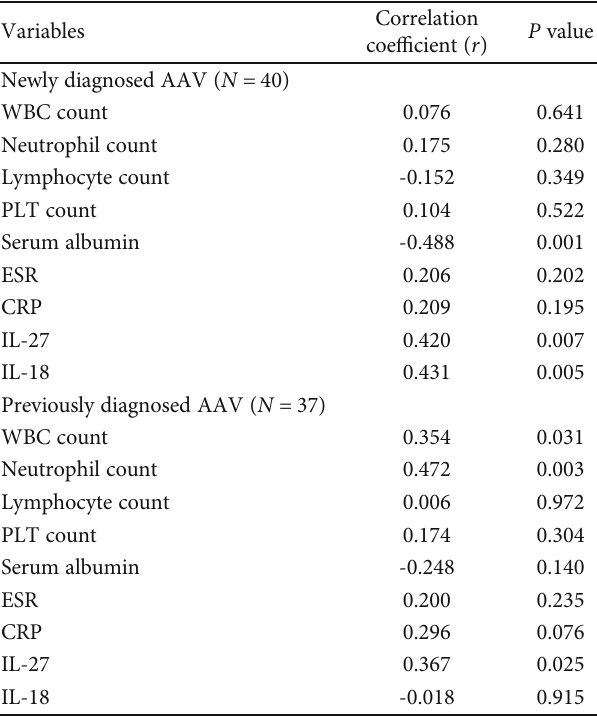
Table 6: Correlation of in fl ammation-related variables and serum IL-27 and IL-18 levels with BVAS according to the time of diagnosis. Variables